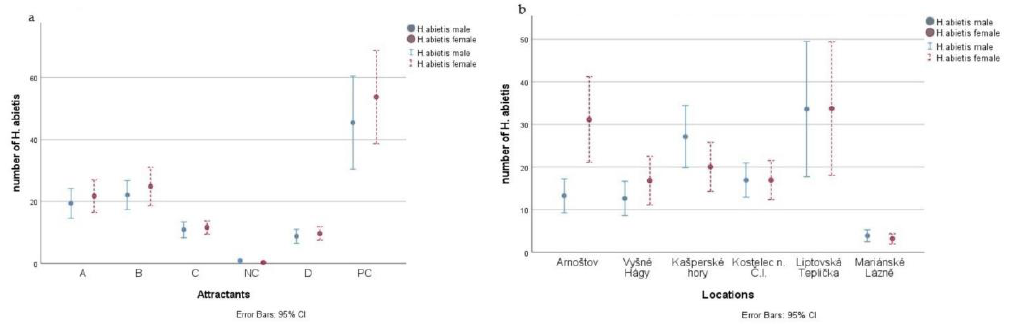
Figure 5. Number (mean ± SE) of H. abietis trapped with individual attractants across all localities ( a ) and at individual localities across all attractant treatments including the control ( b ) (for attractant abbreviations, see Figure 1) .